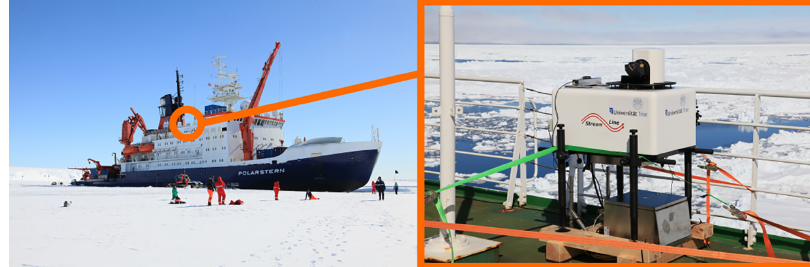
Figure 2. Position of the lidar on the RV Polarstern .